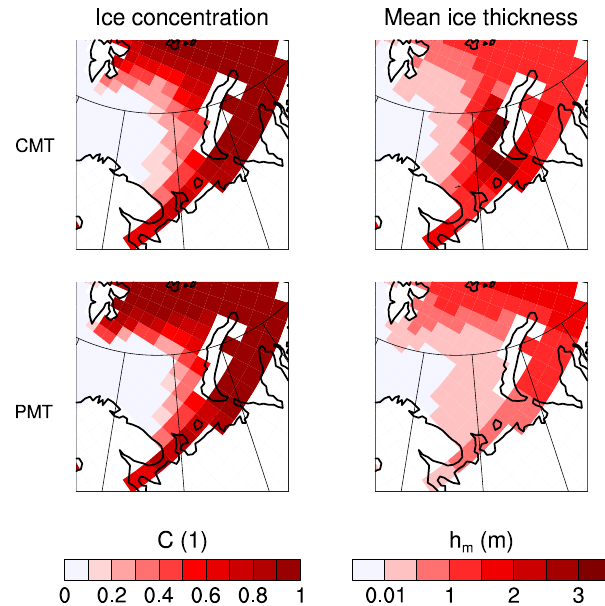
Fig. 7. Average March conditions 1990–1999 when assimilating ob- served sea-ice concentration in the AOGCM with the CMT method (top) and the PMT method (bottom). Ice concentration (left) is sim- ilar between CMT and PMT, and quite close to observations. How- ever, mean ice thickness (right) is much too high for CMT, and re- alistic for